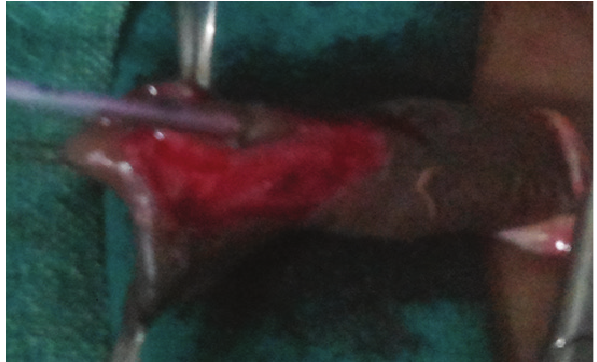
Figure 1: Urethral plate ready for tubularization